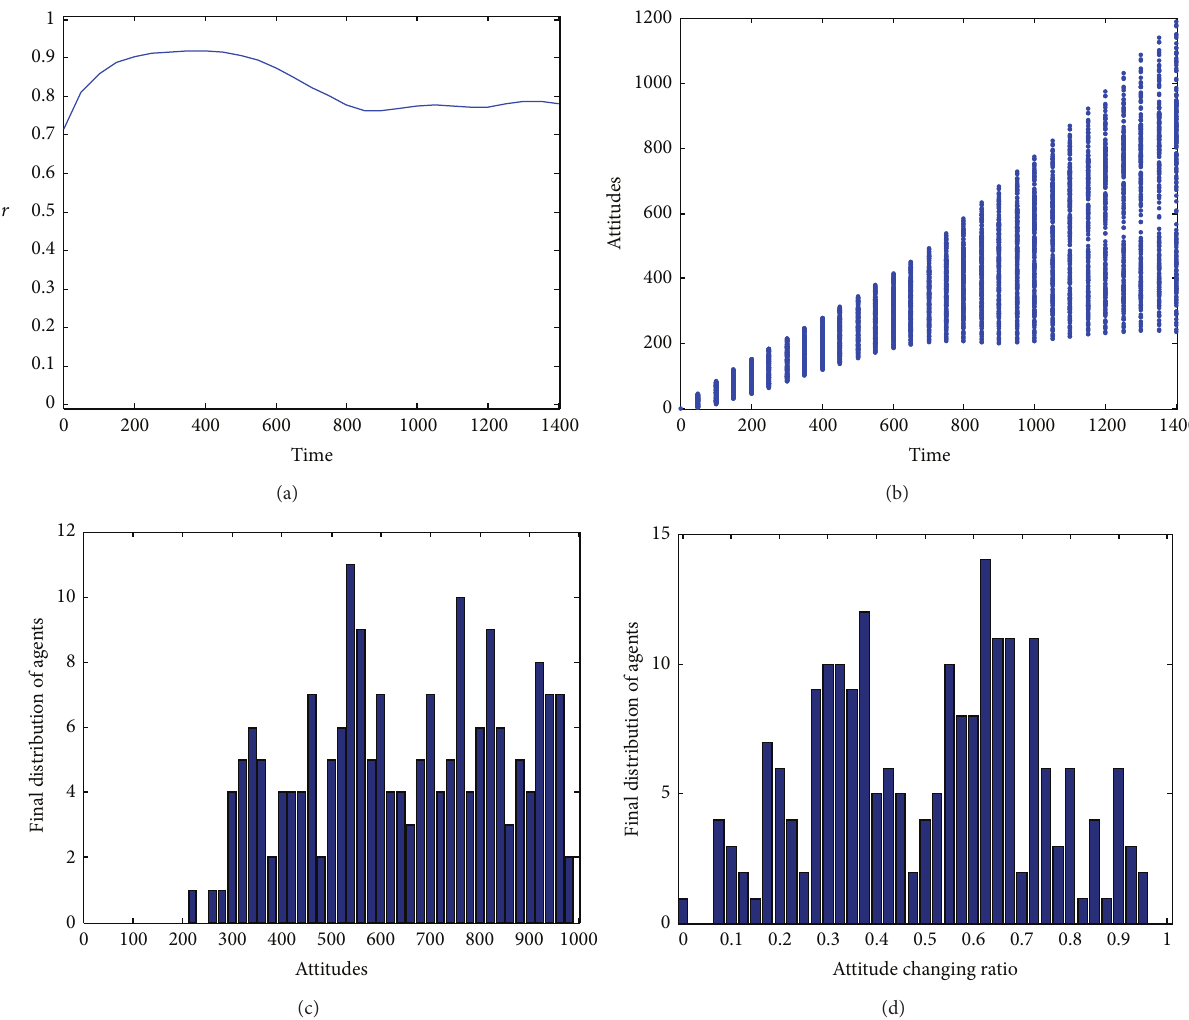
Figure 2: Results of simulation system with 𝐾 = 0.5 . (a) is the subfigure which shows synchronization criterion 𝑟 changes with time; (b) is the subfigure which shows group attitudes 𝑥(𝑡) versus time; (c) is the histogram of the final distribution of agents versus group attitudes 𝑥(𝑡) ; (d) is the histogram of the final distribution of agents versus attitude changing ratio ̇𝑥 𝑖 (𝑡)